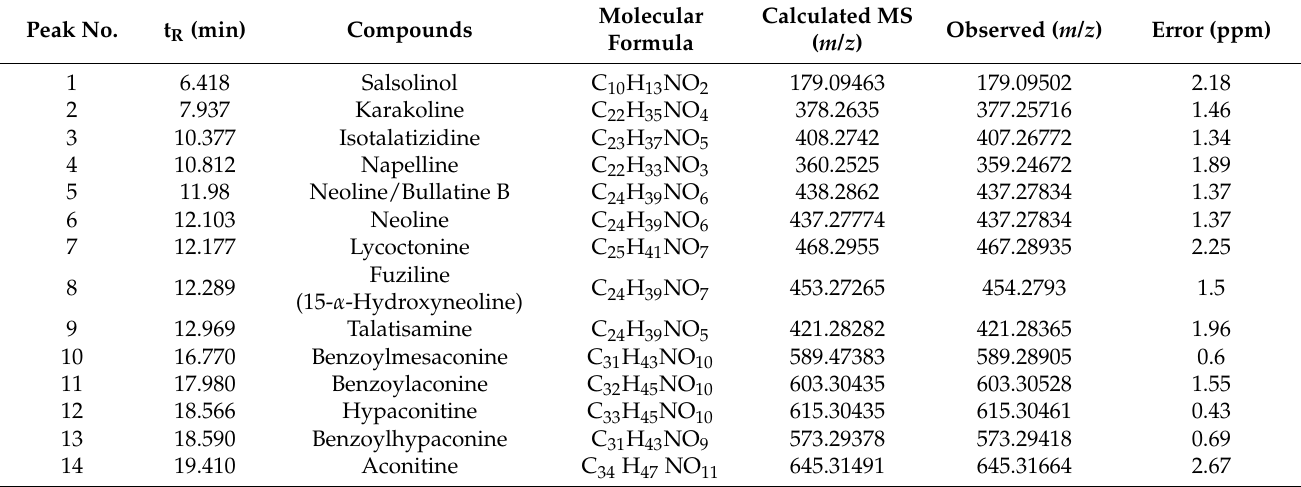
Table 1. The identification of bioactive compounds in WETA by full MS/dd-MS 2 [22]. Peak